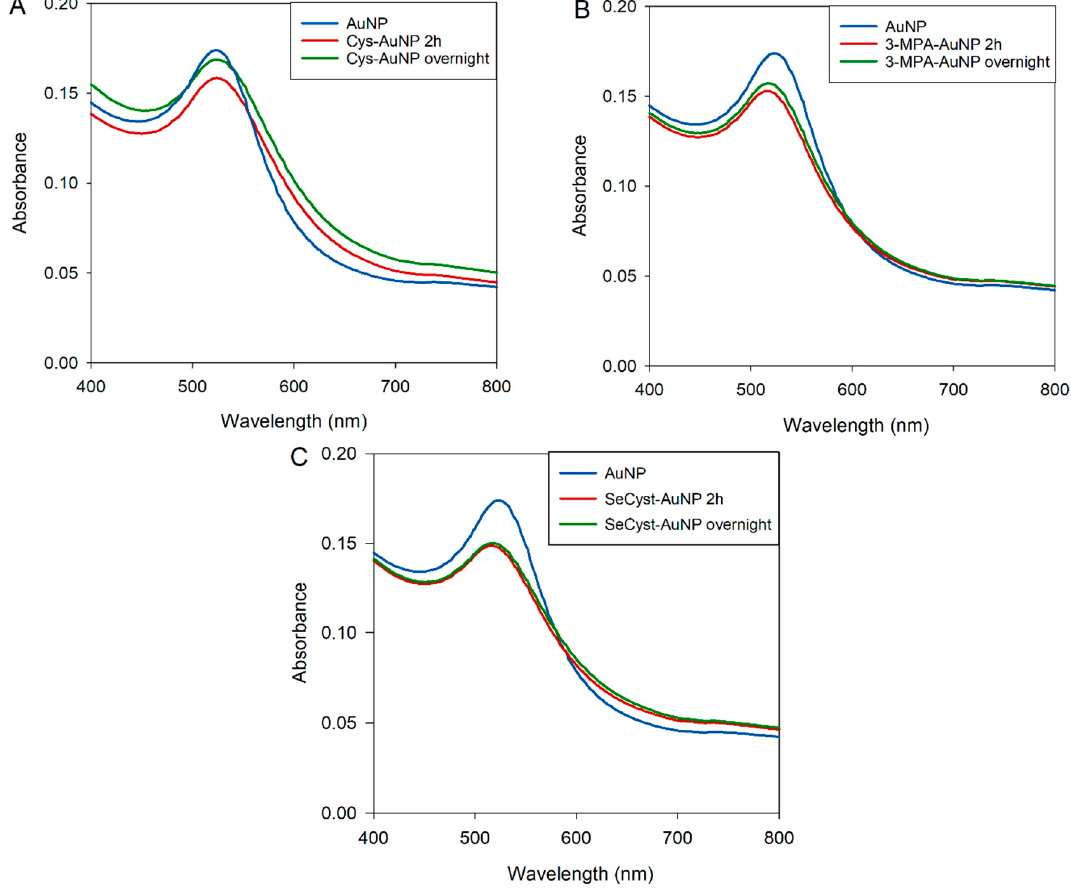
Figure 1. UV-vis spectra for stability assessment of ( A ) Cys-AuNP, ( B ) 3-MPA-AuNP, and ( C ) SeCyst-AuNP in water at 1:2 ratio after 2 h and overnight incubation, at approximately pH 10.